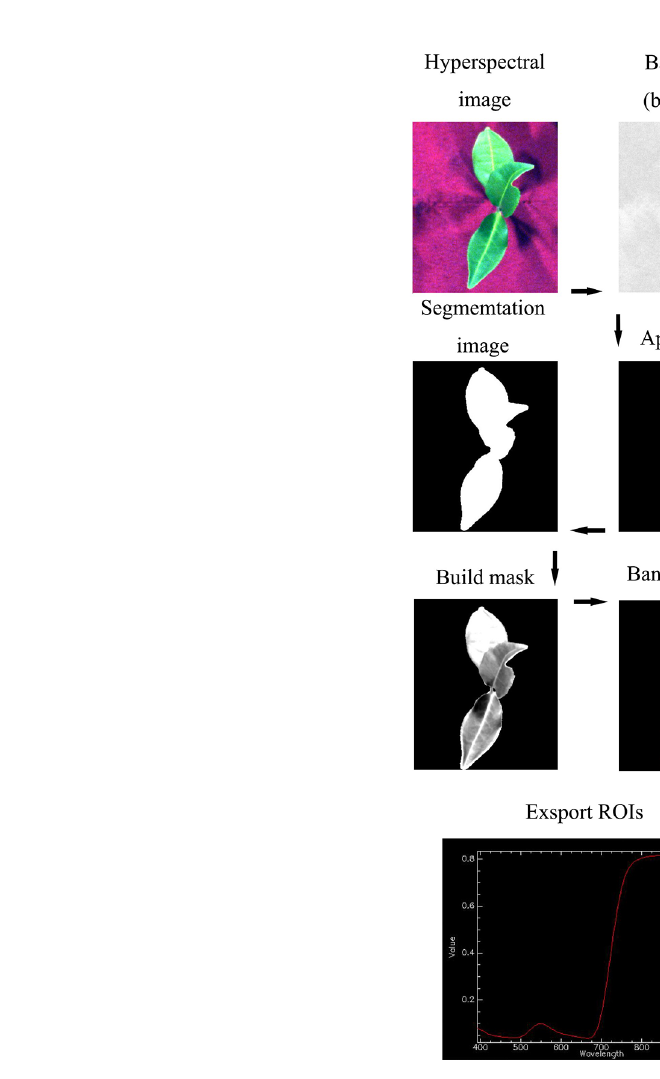
FIGURE 2 Flowchart of spectral data